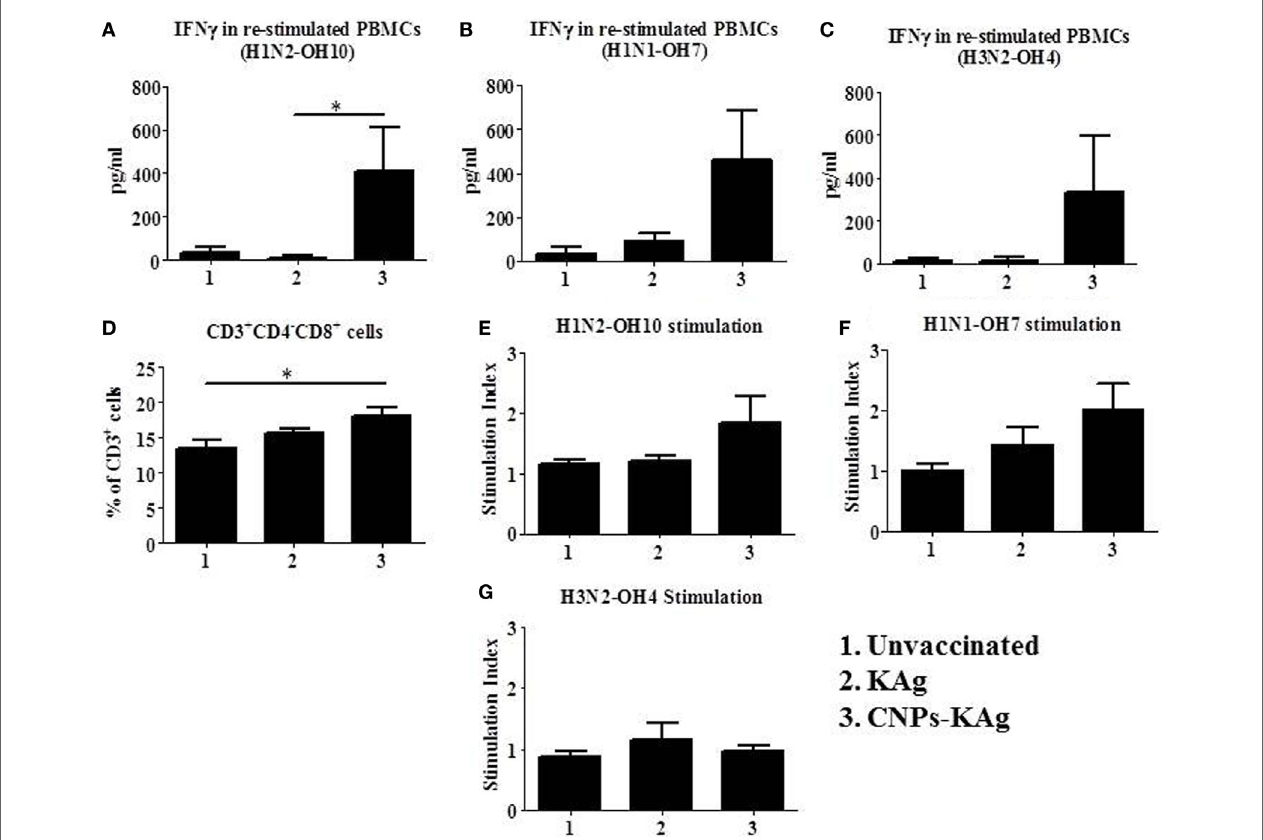
FigUre 7 | Cell-mediated immune response after prime-boost vaccination was enhanced in chitosan nanoparticles (CNPs)-KAg-vaccinated pigs at pre-challenge days post-vaccination (DPV) 35/ day post-challenge (DPC) 0. Peripheral blood mononuclear cells (PBMCs) isolated from blood were stimulated with different variant influenza A virus (IAVs). IFN γ secretion in the culture supernatant and antigen-specific lymphocyte proliferation was determined after 72 h of stimulation with (a,e) H1N2-OH10, (B,F) H1N1-OH7, and (c,g) H3N2-OH4 IAVs. (D) Flow cytometry analysis of PBMCs showed enhanced frequency of CTLs (CD3 + CD4 − CD8 αβ + ) in CNPs-KAg-vaccinated pigs. Data represent the mean value of three to five pigs ± SEM. Statistical analysis was carried out using Kruskal–Wallis test followed by Dunn’s post hoc test. Asterisk refers to the statistical significant difference between the indicated two pig groups (* p <